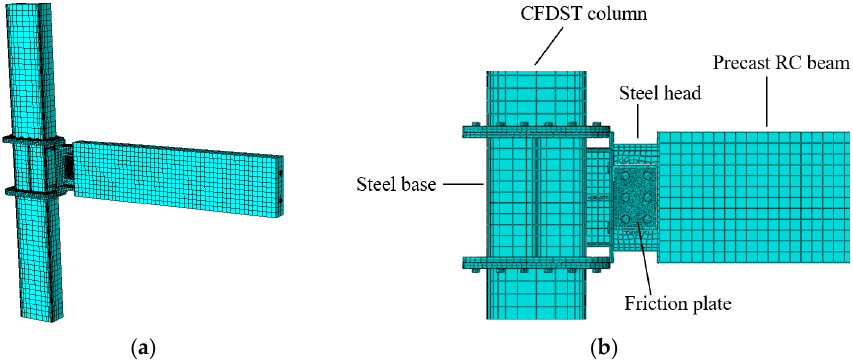
( b ) Figure 9. Loading protocol: ( a ) Boundary conditions; ( b ) Loading history. An axial load of 370.25 kN was applied to the column, which was about 10% of the axial bearing capacity of the column. The design value of the maximum bending moment of the joint was 259.7 kN ∙ m, and the opening moment of the joint was taken as 50% of the design value of the yield, which was 130 kN ∙ m. In order to ensure the self-centering per- formance of the joint, the tensile moment should be greater than the friction moment. Therefore, the tensile moment in the opening moment of the joint accounted for 60%, and the friction moment accounted for 40%. Accordingly, the bolt preload was 54.5 kN and the prestress of steel strands was 572 MPa. The displacement loading method was adopted for the cyclic loading at the beam end. In order to investigate the joint rotation angle when